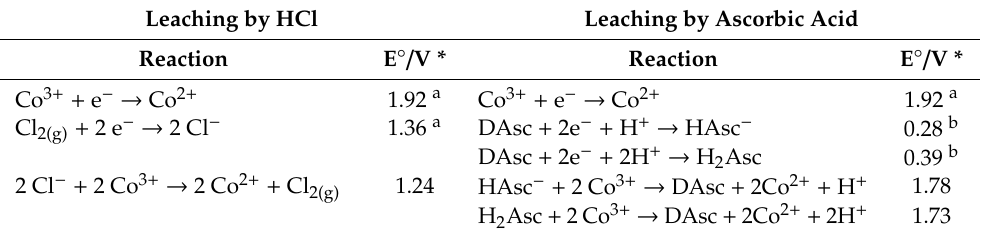
Table 1. Redox reaction of cobalt involved in spent lithium-ion batteries (LIBs) leaching. Leaching by HCl Leaching by Ascorbic Acid